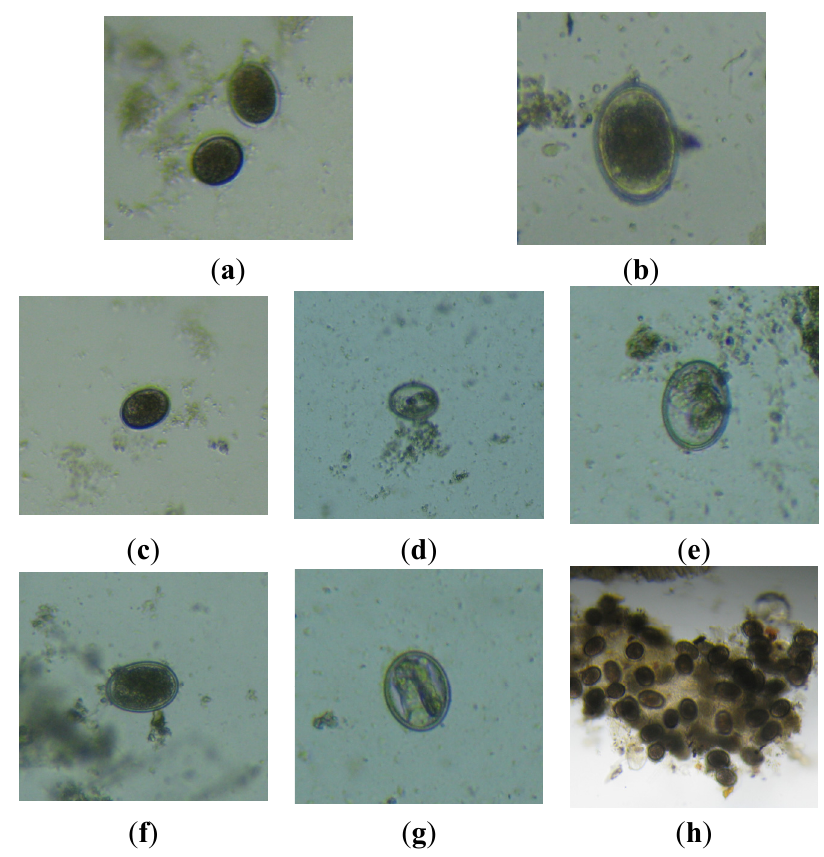
Figure 10. Helminth eggs in the influent ( a ) and in the effluent ( b ) for an applied upflow velocity of 0.09 m·h − 1 . Helminth eggs in the influent ( c ) and in the effluent ( d ) and ( e ) for an upflow velocity of 0.34 m·h − 1 . Helminth eggs from the effluent show an internal morphology likely affected by the experimental conditions. Helminth eggs in the influent ( f ) and in the effluent ( g ) and ( h ) of lab-scale UASB reactor for an upflow velocity of 0.68 m·h − 1 . Helminth eggs from the effluent ( g ) show an apparently deteriorated semi-crystalline internal morphology (possible larval development but interrupted by the conditions of the experiment) and ( h ) group of attached helminth